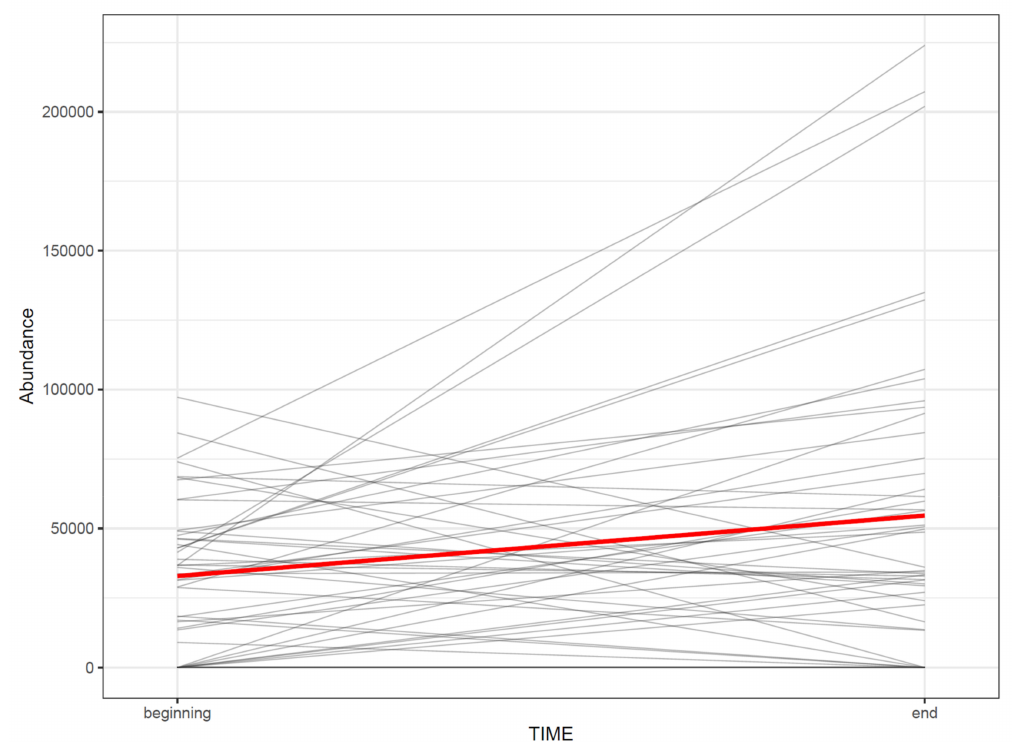
Figure 15. The change in the abundance of a molecular feature as a function of time in each subject. The thick red line represents the sample mean.